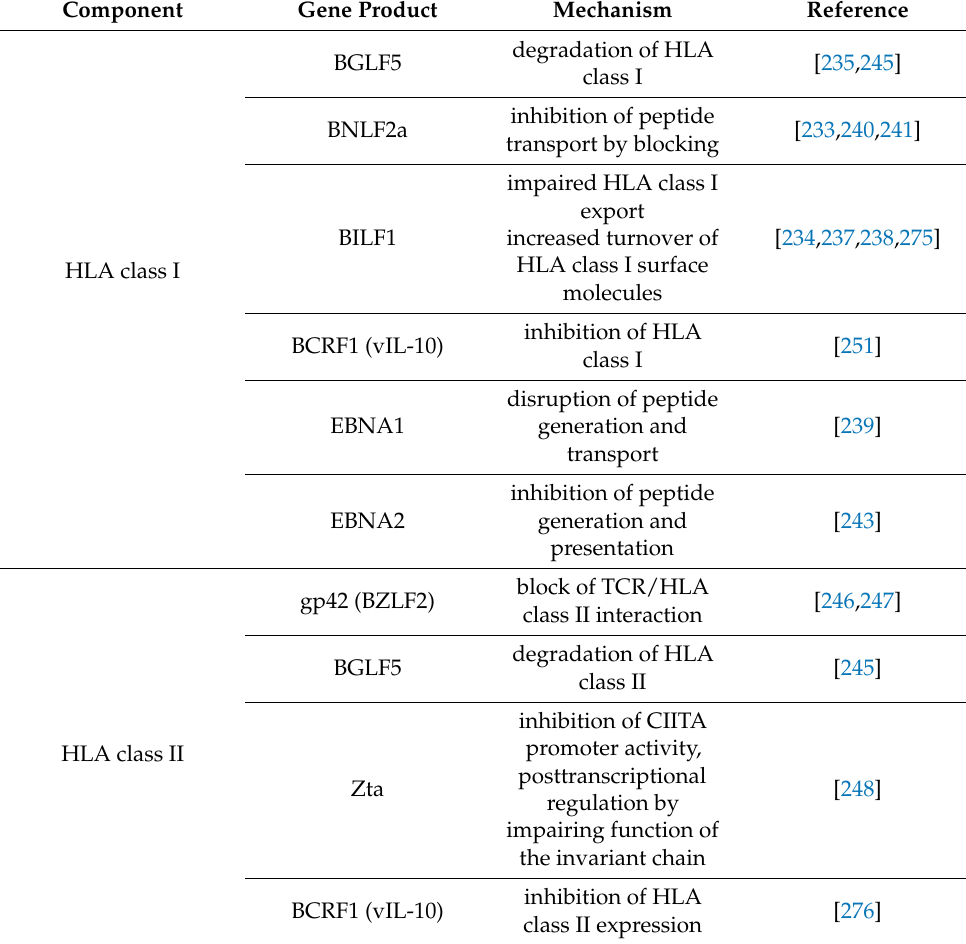
Table 6. Immune escape mechanisms and EBV-encoded gene products